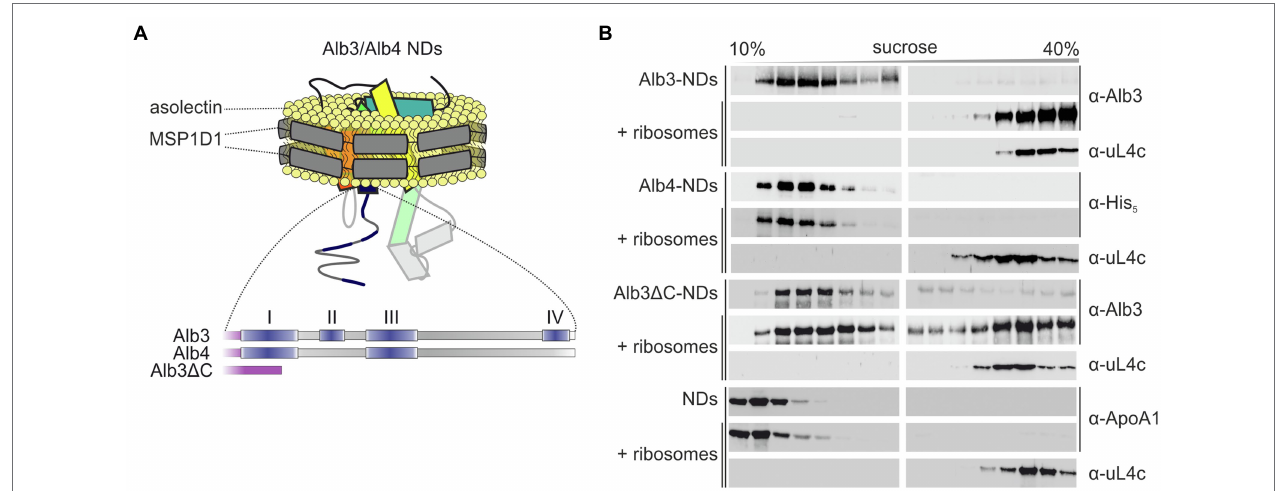
FIGURE 3 | Sucrose gradient interaction assay of Alb3 variants and Alb4 reconstituted in nanodiscs with chloroplast ribosomes. (A) Schematic representation of recombinant His-tagged full-length mature Alb3 (amino acids 55–462), Alb3 Δ C (amino acids 55–369) and Alb4 (amino acids 46–499) reconstituted in MSP1D1 nanodiscs (NDs; not to scale) with asolectin as bilayer forming lipid. (B) Nanodiscs (NDs) containing Alb3 (Alb3-NDs), Alb4 (Alb4-NDs), or Alb3 Δ C (Alb3 Δ C-NDs) and NDs without inserted membrane protein as negative control were incubated with chloroplast ribosomes and loaded onto a sucrose density gradient. After ultracentrifugation, the gradient fractions were analyzed immunologically using antibodies against the His-tag ( α -His), A. thaliana chloroplast Alb3 ( α -Alb3), human Apolipoprotein A1 ( α -ApoA1; the wildtype template of MSP1D1) and the chloroplast ribosomal protein uL4c ( α -uL4c). Sucrose density gradient centrifugation of the Alb constructs, containing NDs in the absence of ribosomes was used as negative